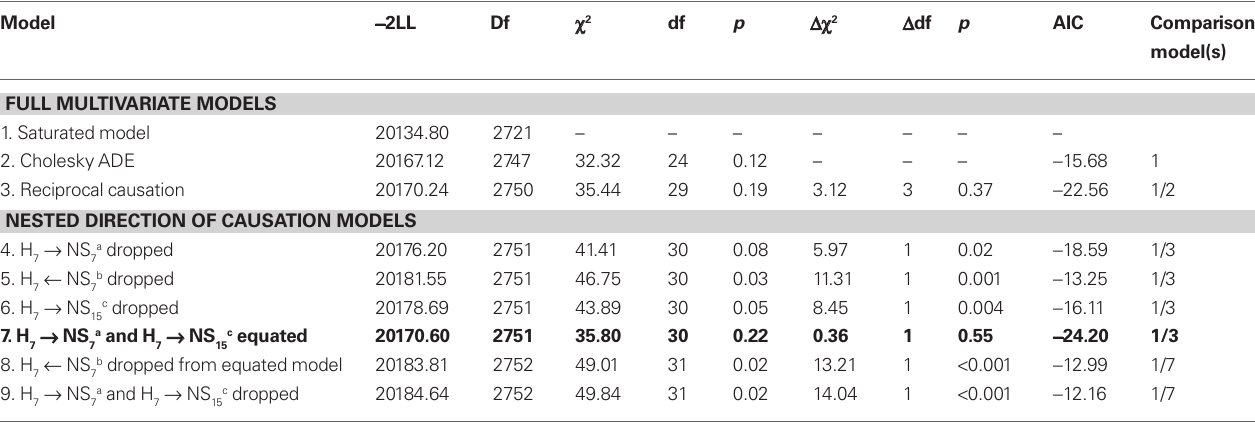
Table 2 | Fit of structural equation models examining the etiology between and within hyperactivity–impulsivity age 7, novelty seeking age 7, and novelty seeking age 15.